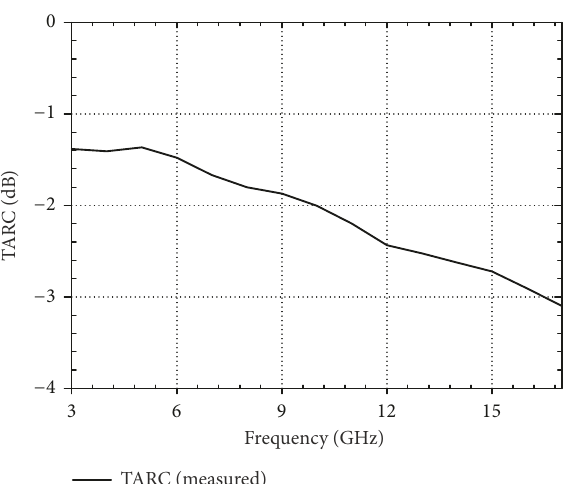
Figure 10: TARC for the proposed MIMO